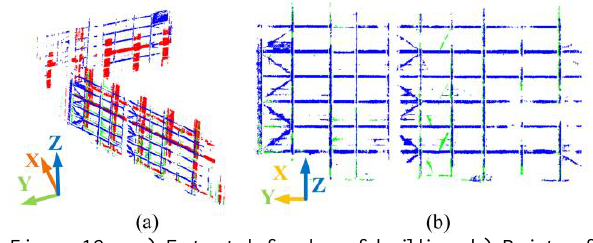
Figure 12. a) Extracted facades of building. b) Points of scaffolds in a facade.